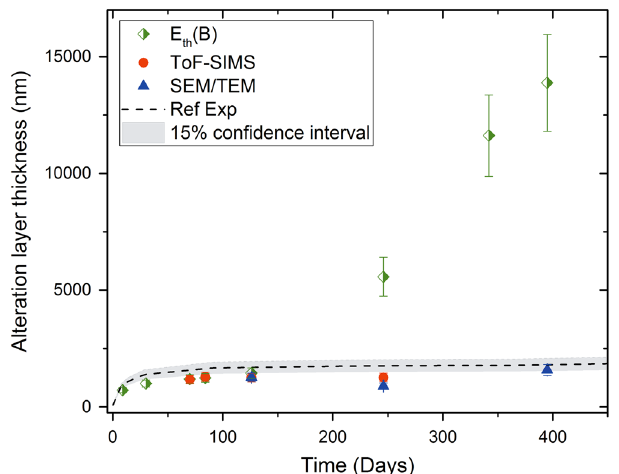
Fig. 11 Comparison of alteration layer thickness measurements. Agreement within all techniques is seen until alteration resumption. Physical measurements of the polished side of the monolith remain in agreement with the reference experiment. 30 Changes determined by increased concentrations of boron in solution highlight the effect of the alteration at surface cracks on the non-polished sides. Dotted line represents the alteration layer thicknesses determined in the reference experiment along with the corresponding 15% con fi dence